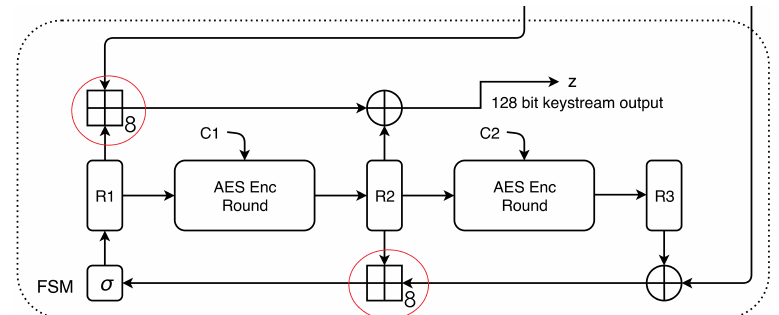
Figure 6: The FSM part of SNOW-V (cid:1)